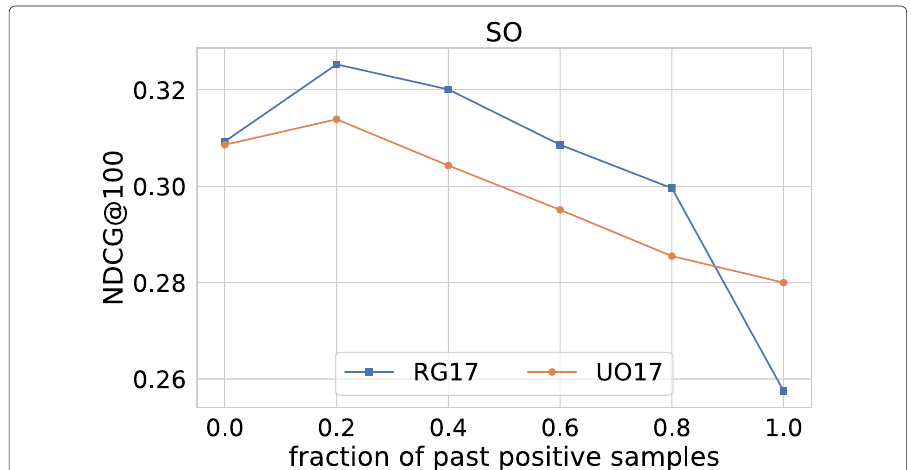
Fig. 9 The effect of past positive samples used as negative samples for SO when the latest edge